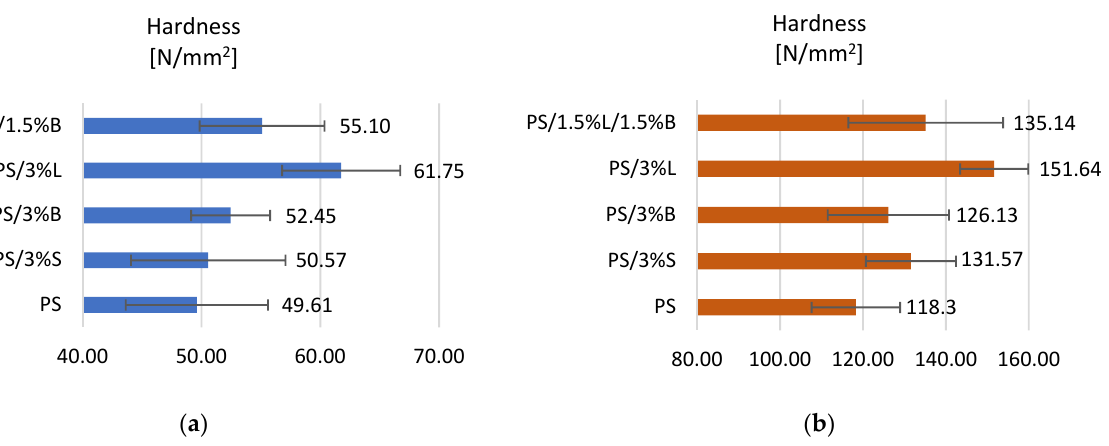
Figure 4. Hardness test results of ( a ) samples obtained by 3D printing, ( b ) samples obtained by injection molding.